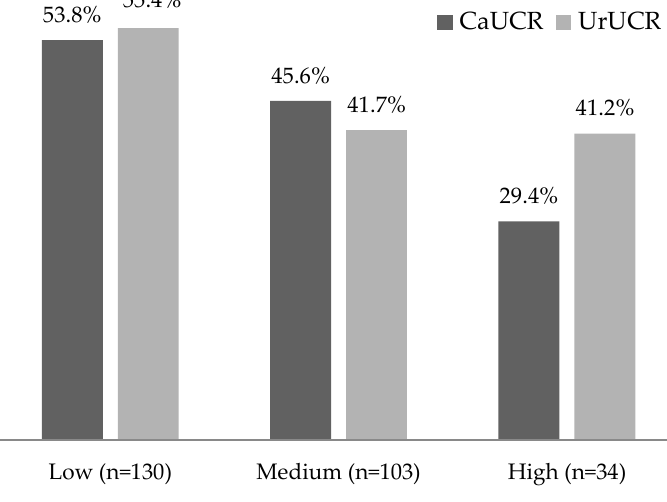
Figure 1. Percentage of subjects with high calcium urinary crystallization risk (CaUCR) and high uric acid urinary crystallization risk (UrUCR) who had low, medium, and high adherence to the MedDiet. Chi-squared tests indicated that high CaUCR had a significant association with diet ( p = 0.012) and high UrUCR had a marginal association with diet ( p = 0.079).